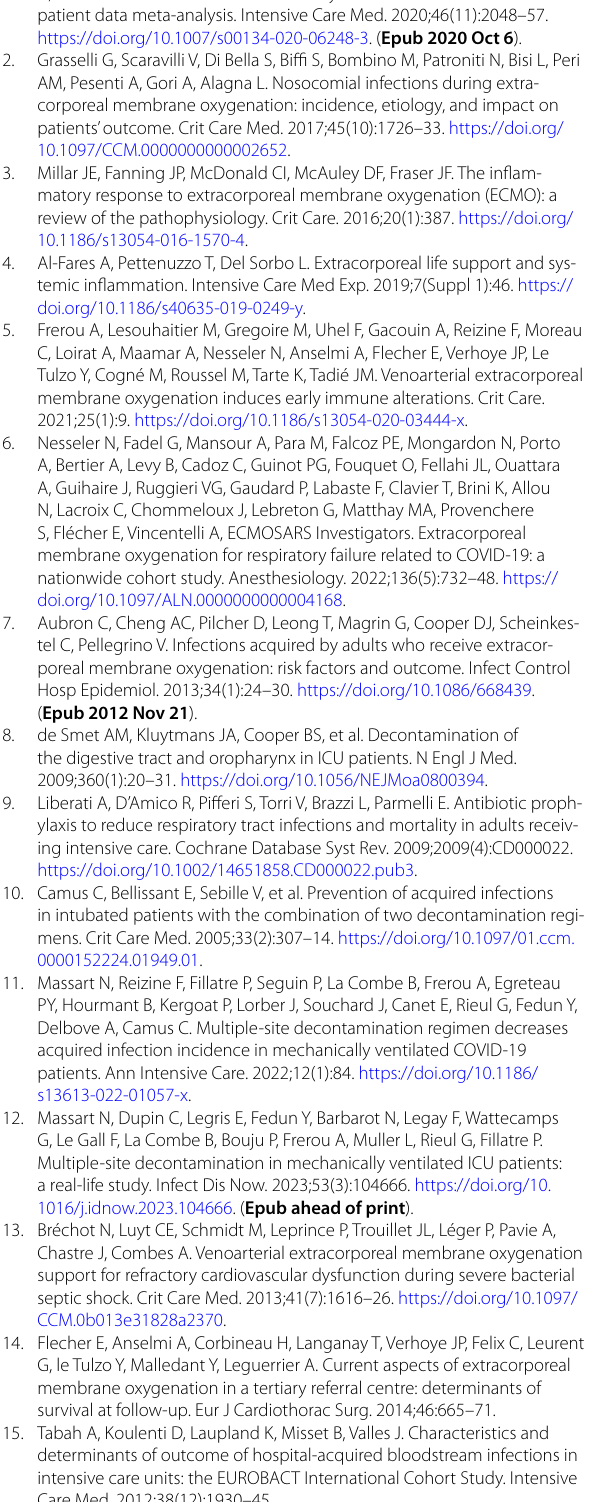
Table S3. Baseline characteristics and outcomes of matched